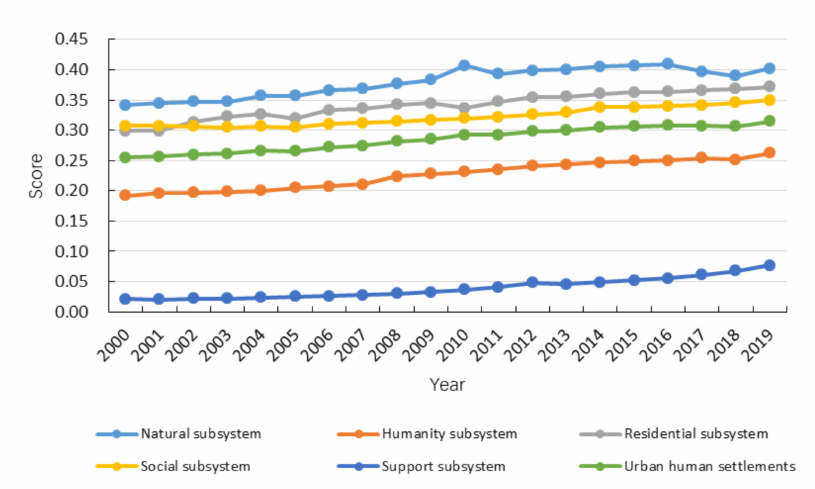
Figure 1. Trend chart of inter-annual sustainable development level of urban human settlements and subsystems in